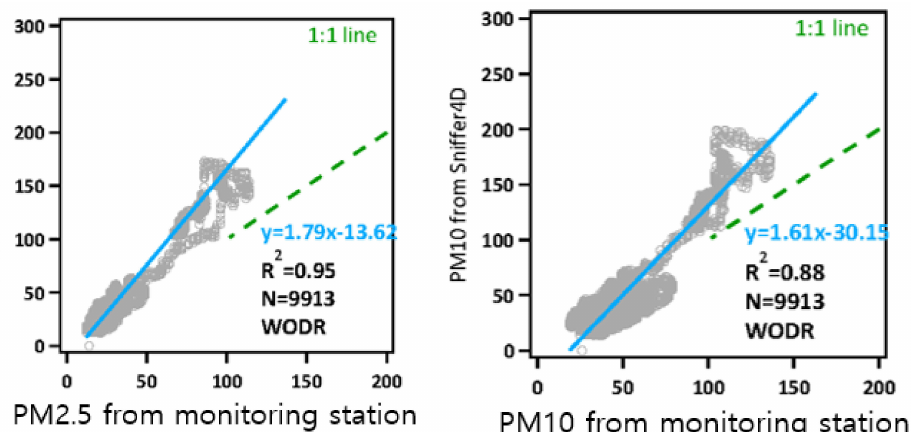
Figure 3. Reliability of the Sniffer4D sensor (PM 2.5 and PM 10